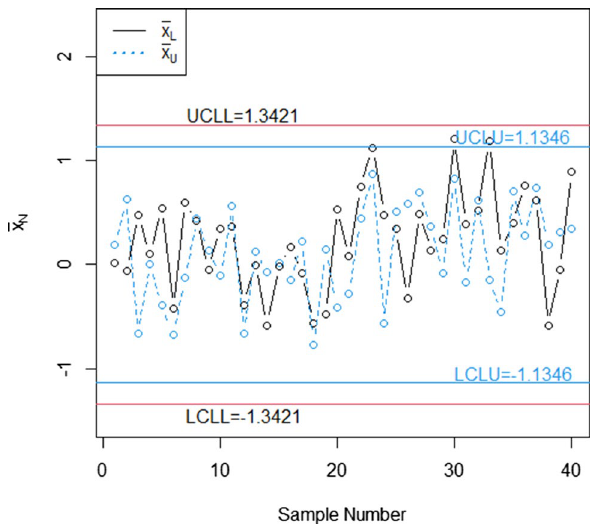
Fig. 3 The control chart proposed by [29] for simulated data